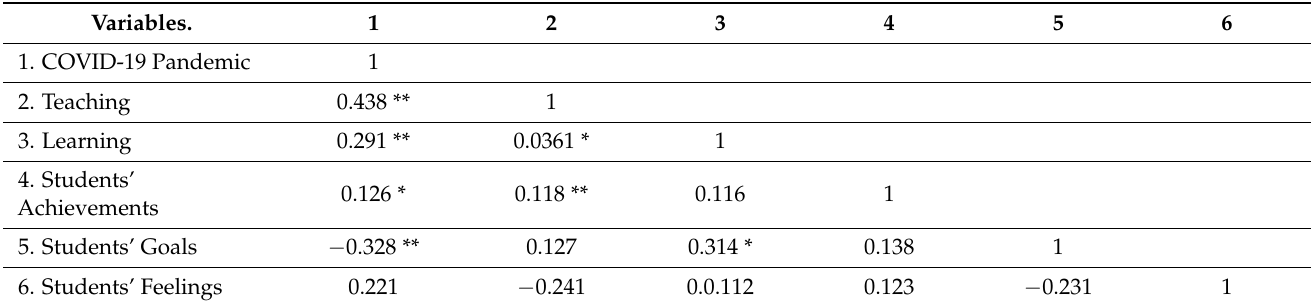
Table 10. Correlation matrix among independent variable (COVID-19) and dependent variables.